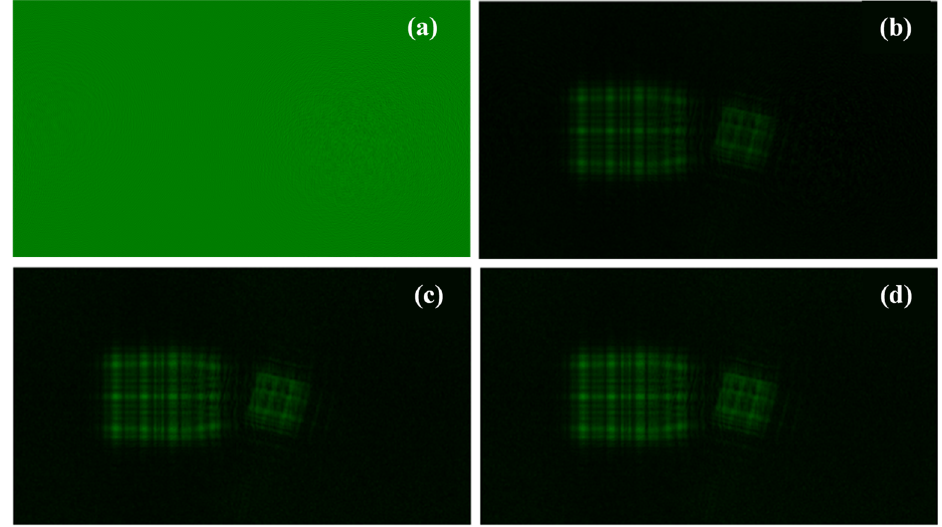
Figure 5. Four kinds of encoded holograms with FHD resolution. Encoding methods to be used are CAO encoding ( a ), MAO encoding ( b ), Burckhardt’s encoding ( c ), and Lee’s encoding ( d ).